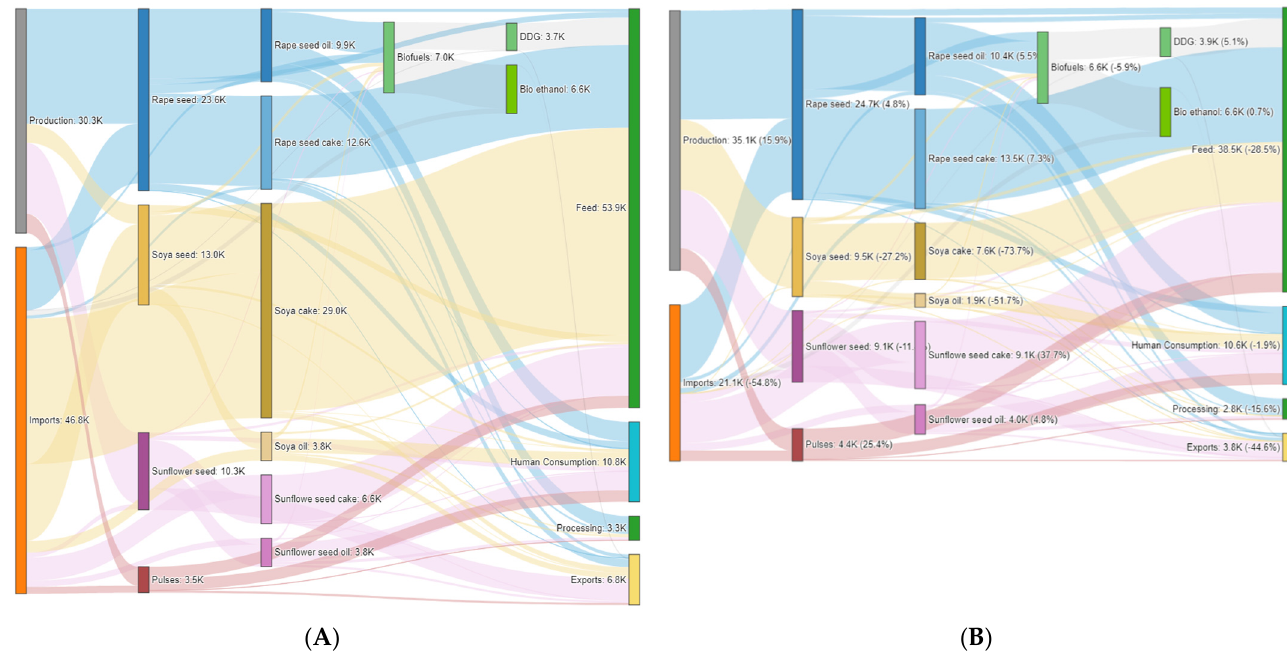
Figure 2. Elements of the market balance for the oil and cake markets for the EU, in the baseline and a cease of import scenario, in different tones; ( A ) presents the baseline; ( B ) describes the cease of import scenario. The percentage change compared to the baseline is presented in brackets in ( B ), after the totals in K = 1000 tones. Table 1. Elements of the market balance for the EU—absolute and percentage changes to the baseline for cereals, sugar, and meat